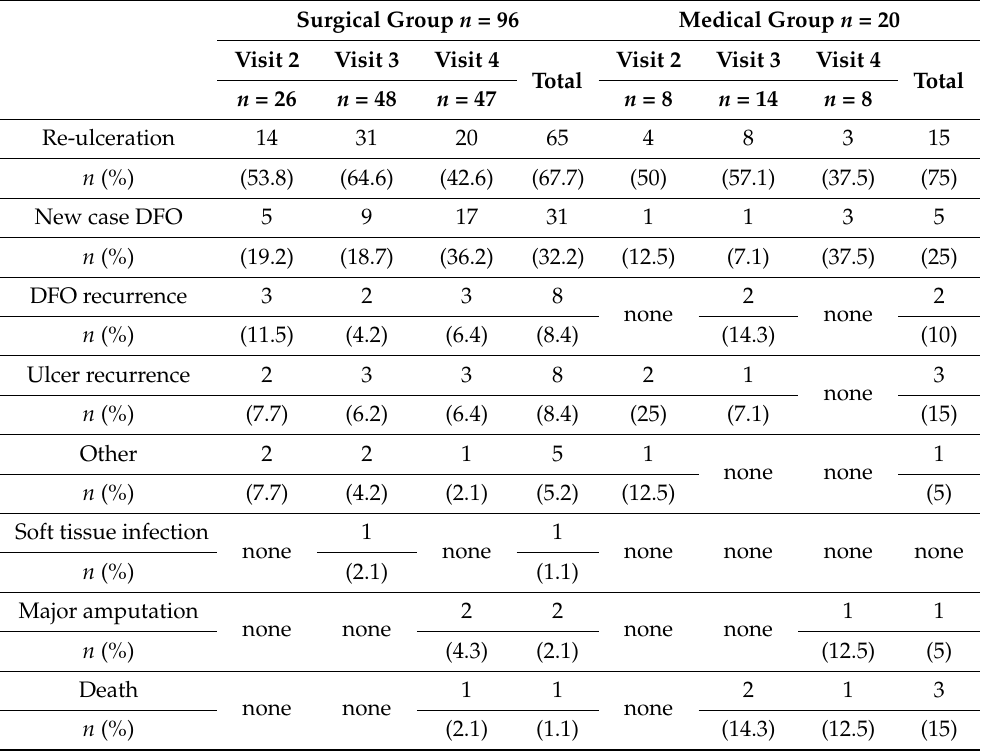
Figure 1. Flow chart of the distribution of complications. Abbreviation: DFO, diabetic foot osteomyelitis. Table 2. Surgical versus medical complications.